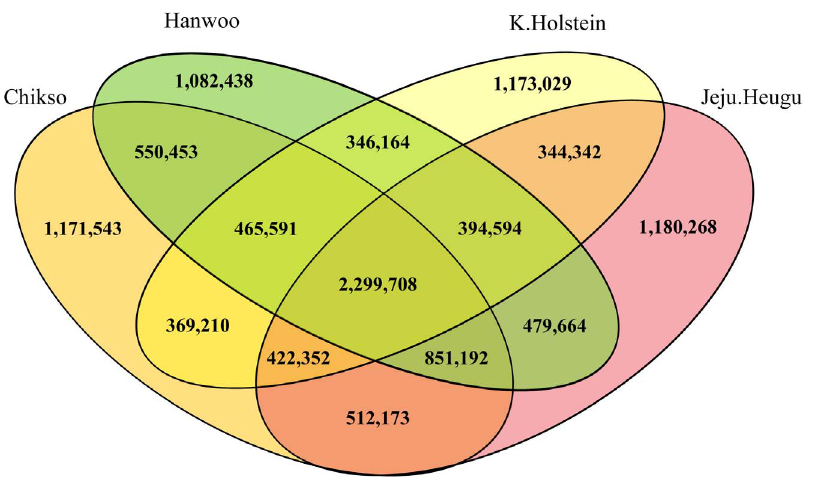
Figure 2. Venn diagram showing the overlap of all detected single nucleotide polymorphisms in the Hanwoo, Jeju Heugu, Chikso, and Korean Holstein genomes.